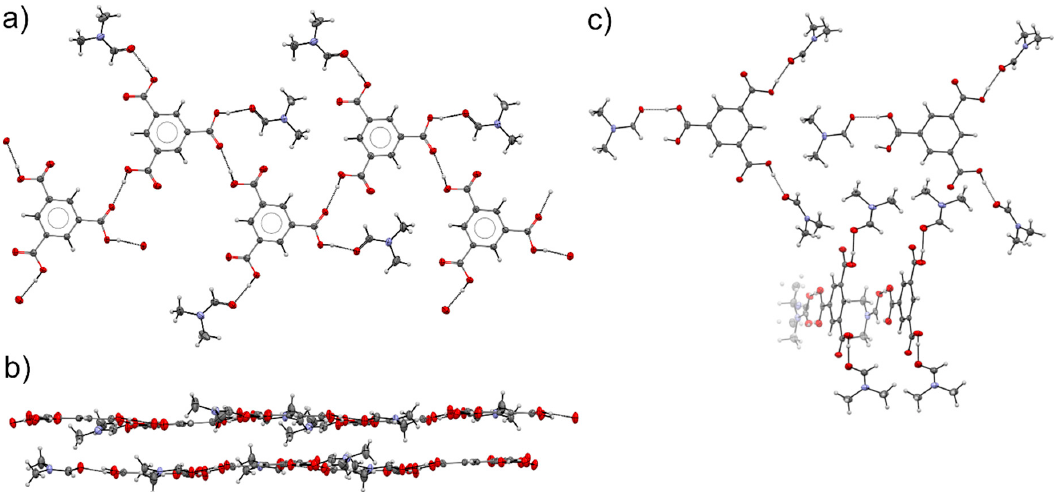
Figure 7. ( a ) The hydrogen bonding pattern in the 1:2 TMA:DMF solvate (XAVPOZ) [17]; ( b ) the layered nature of the 1:2 solvate; ( c ) the hydrogen bonding pattern in the 1:3 TMA:DMF solvate showing the isolated units of TMA surrounded by three DMF molecules. These stacked groups plane with the TMA are disordered over the mirror